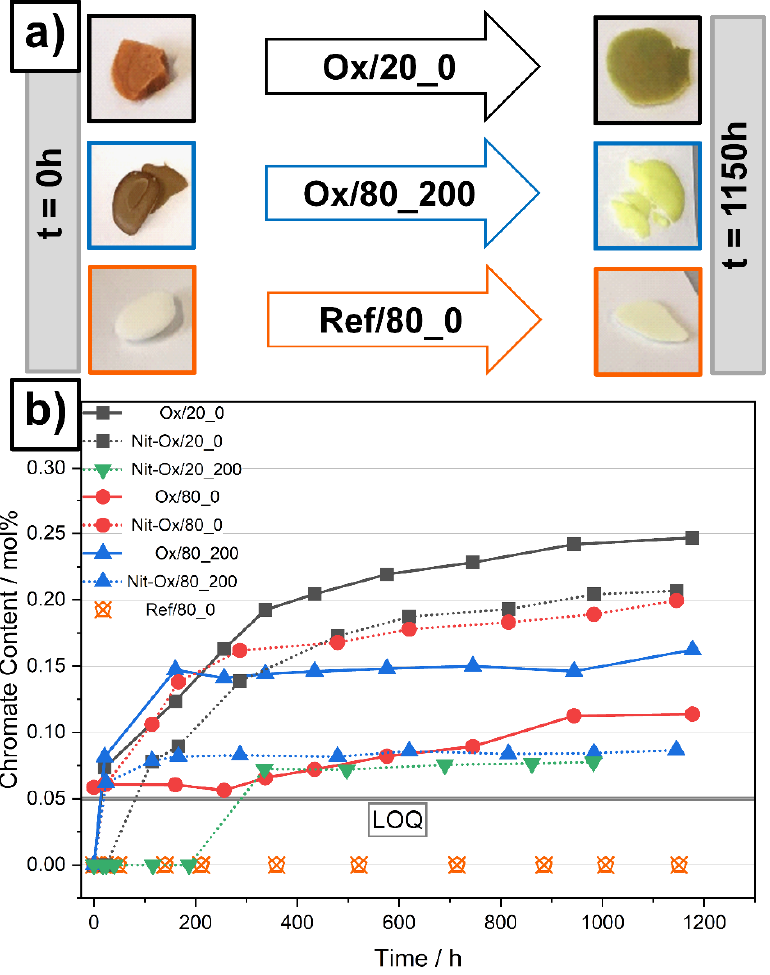
Figure 4. ( a ) Salt sample appearance initially (t = 0 h) and at the end of the experiments (t = 1150 h); ( b ) Chromate content over time of the molten salts. Limit of quantification (LOQ) indicated as gray bar. Reference data shown (Ref/80_0) did not contain oxide impurity. Error bars lay inside symbol.